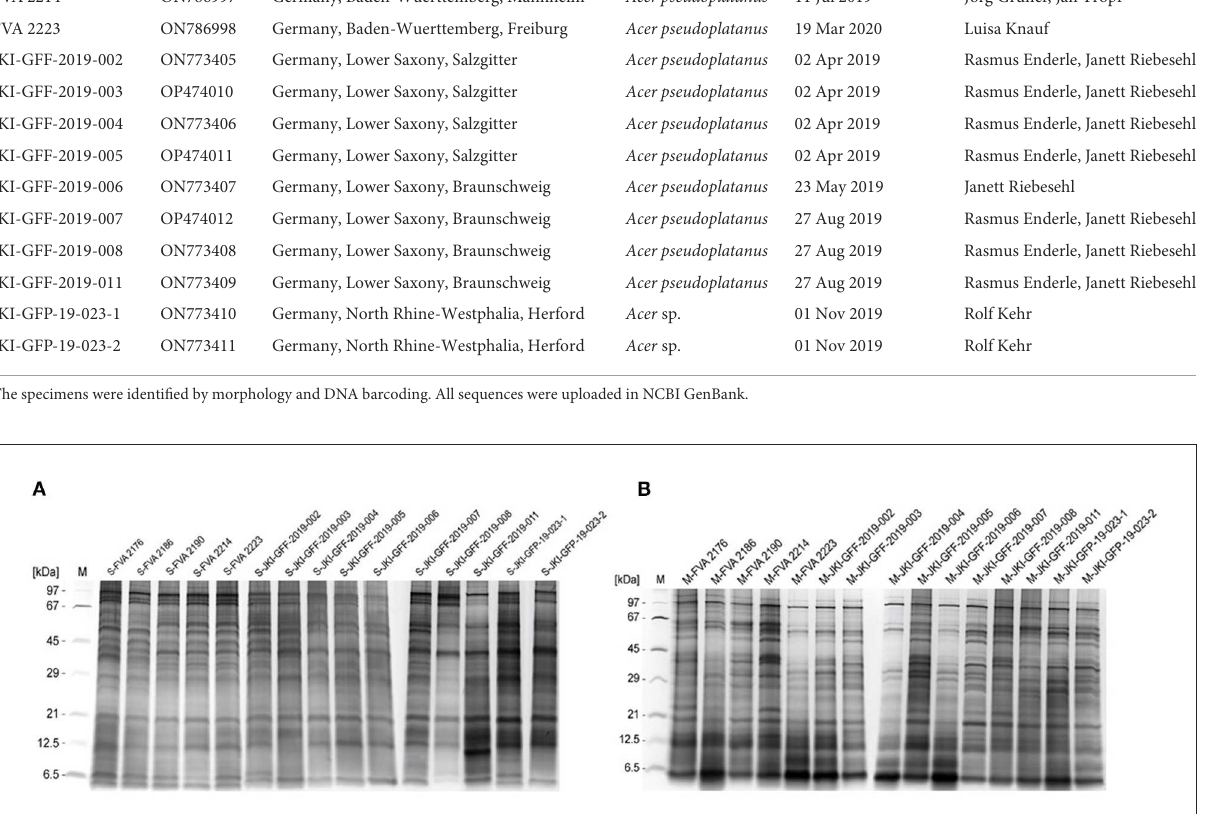
FIGURE4 SDS-Silver-PAGE of spore extracts (A) and mycelia extracts (B) of 15 individual C. corticale specimens and strains which were prepared. The order of the applied extracts from left to right correspond to Table